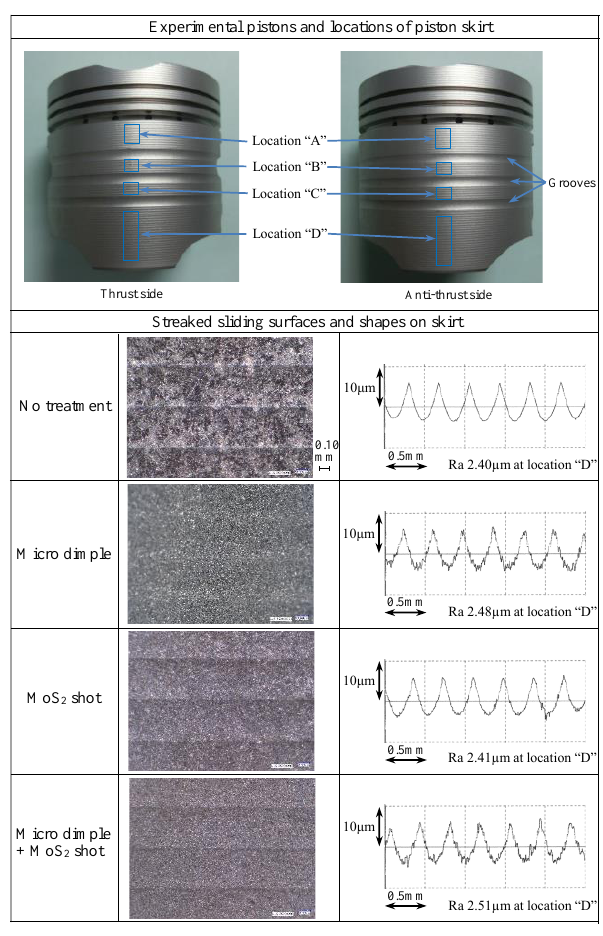
Fig. 3. Experimental pistons and the surface shapes on the piston skirts Table 1. Experimental piston rings